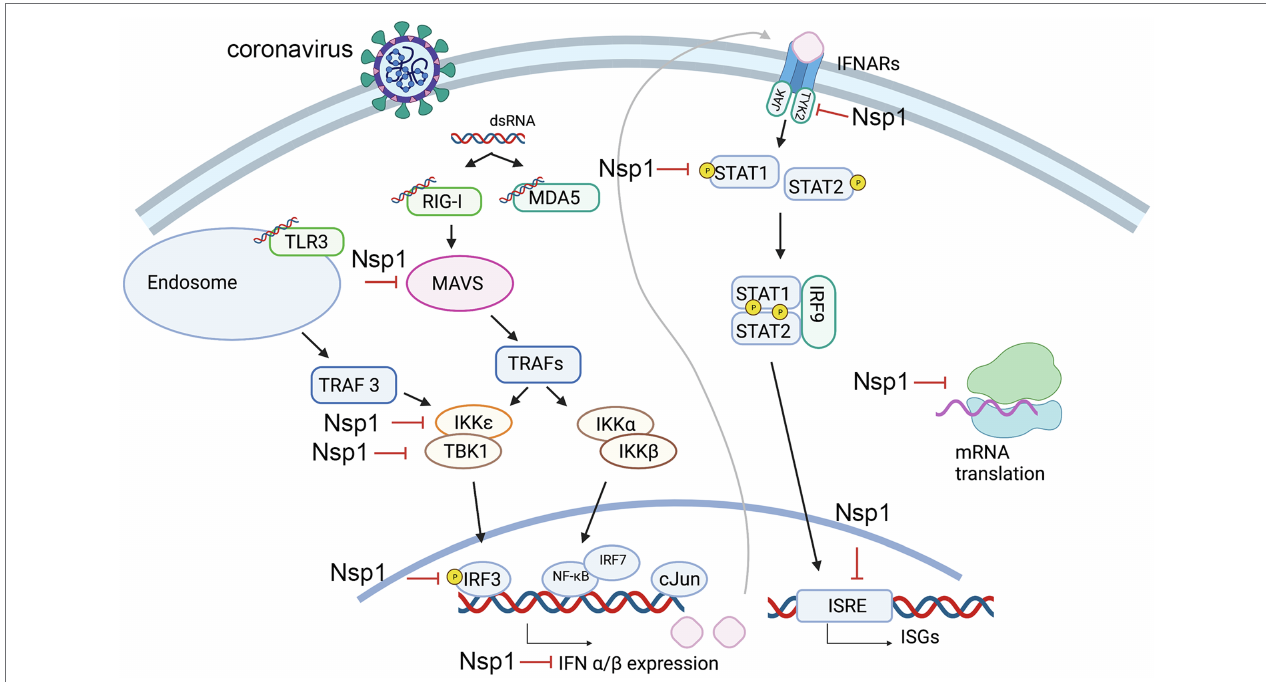
FIGURE 1 | Steps of the innate immune response pathways that potentially be suppressed by nonstructural protein 1 (Nsp1). Key steps that are found inhibited by Nsp1 are